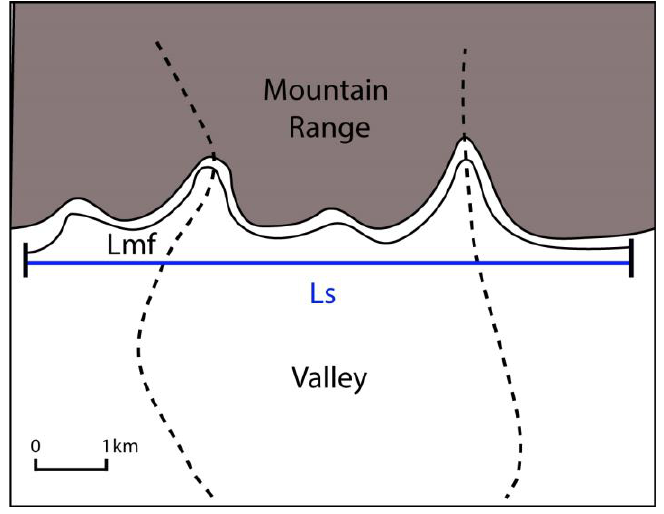
Figure 4. Scheme of calculation of mountain front sinuosity index, S mf .